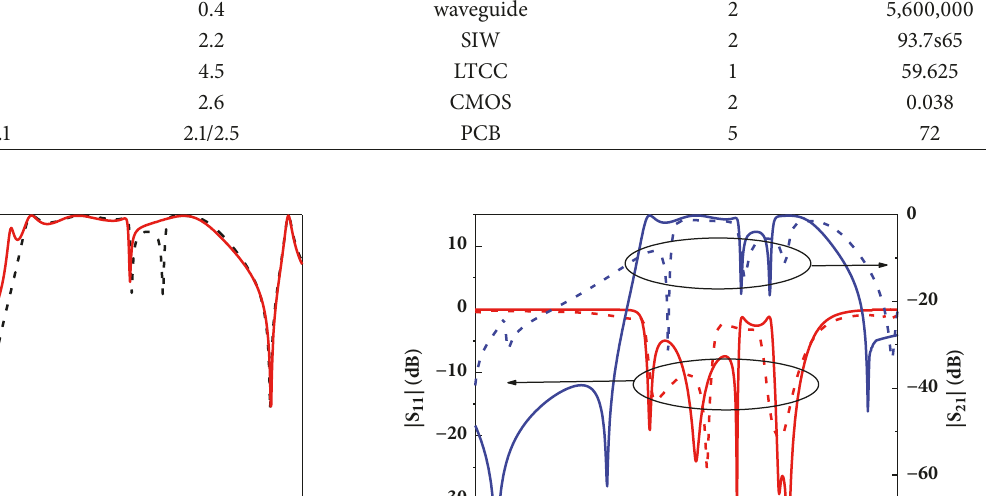
Table 1: Performance comparison between the proposed design and some previously published millimetre-wave filters. Ref.